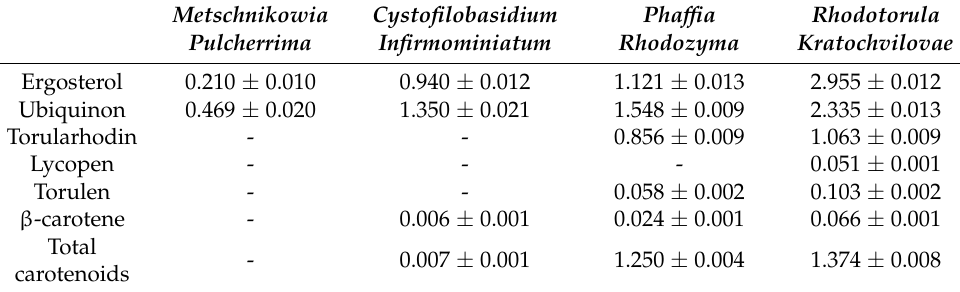
Table 2. Content of carotenoids in biomass [mg/g].